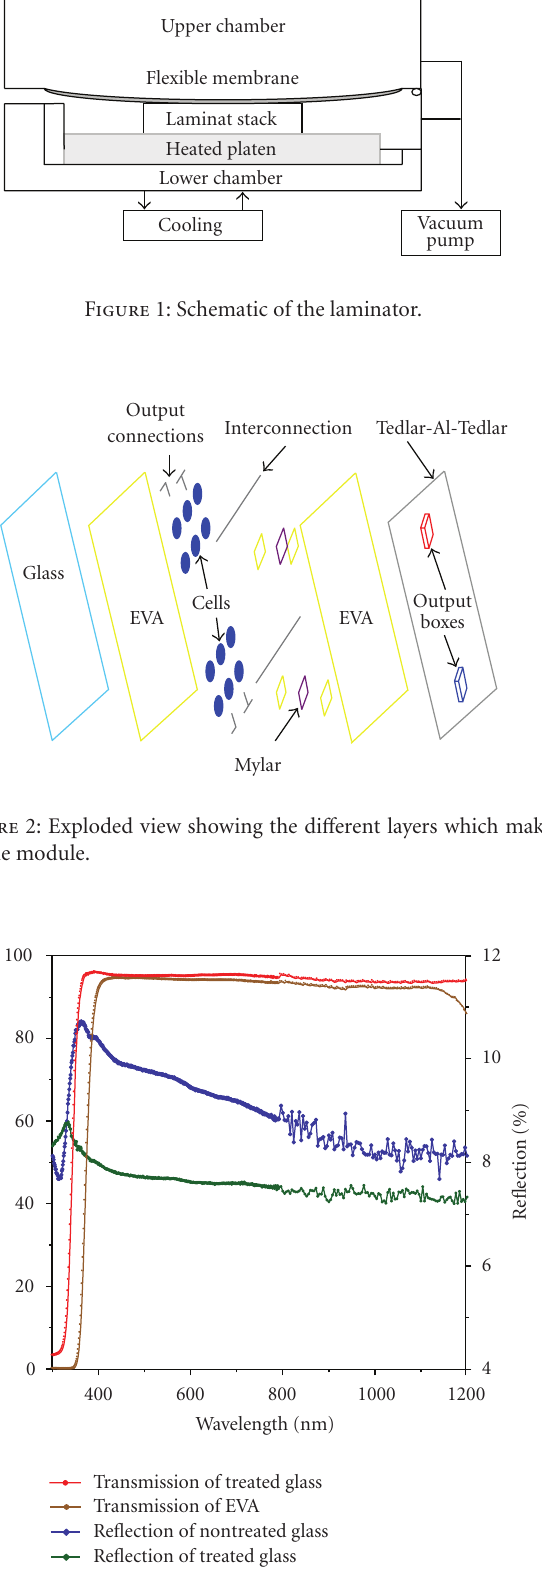
Table 1: Composition of ELVAX 150.